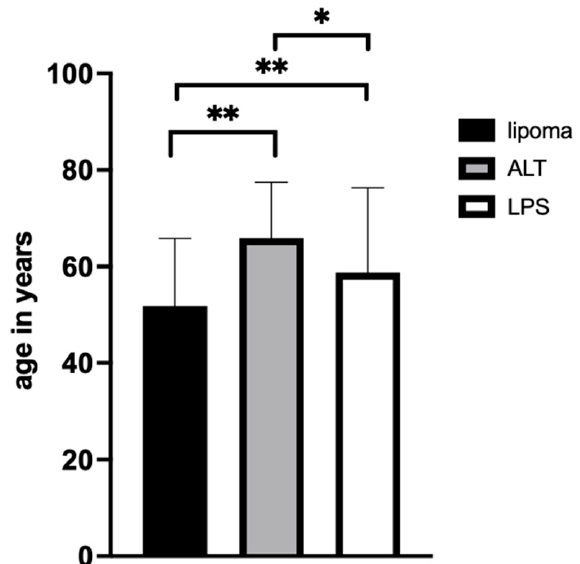
Figure 3. Age distribution of lipomatous tumors at the time of surgery. Patients with lipomas were on average 51.8 ± 14.0 years old. ALTs were more frequent in older people (mean 66.0 ± 11.5 years old). Thus, this cohort was significantly older than patients with lipomas ( p < 0.0003). No significant difference was found in the mean age of patients with an LPS ( p = 0.19). Patients with an LPS had an average age of 58.8 ± 17.5 years; they were significantly older than patients with a lipoma ( p = 0.0146). Normal distribution was proven by a Shapiro–Wilk test. For 2-way statistical analysis, an ANOVA (CI = 95%) was performed. * indicates p < 0.05; ** indicates p < 0.005.